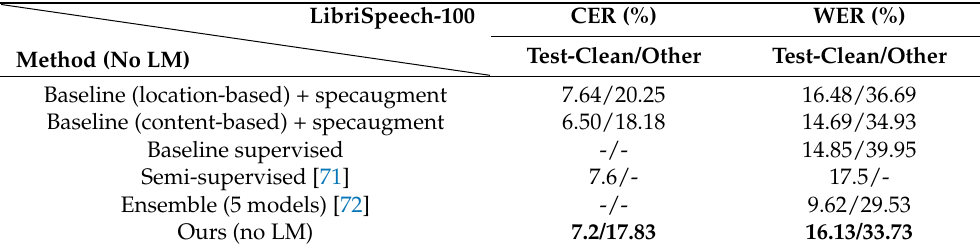
Table 3. The results of the research were obtained using the test-clean and test-other subsets of LibriSpeech Corpus, showing the CER and WER performance (%) of the SOTA hybrid CTC/attention E2E ASR model with two kinds of attention, three supervised models and our proposed model. Our experimental results are highlighted in